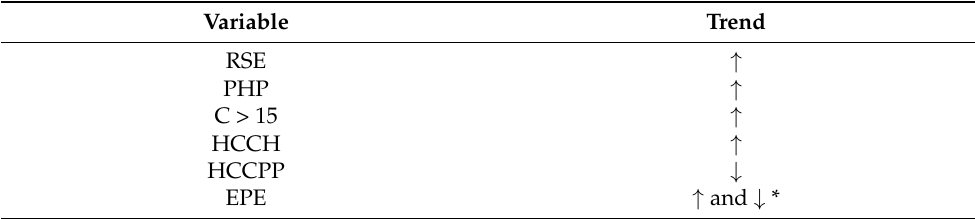
Figure 7. Observed and modelled by MLP value of emission: ( a ) SO 2 ; ( b ) NO x ; ( c ) CO; ( d ) PM. The trends observed for individual input variables (Table 3) led to several hypothetical scenarios of their course and, based on them, predictions of SO 2 , NO x , CO and PM emissions were made. Table 3. The trends observed for individual input